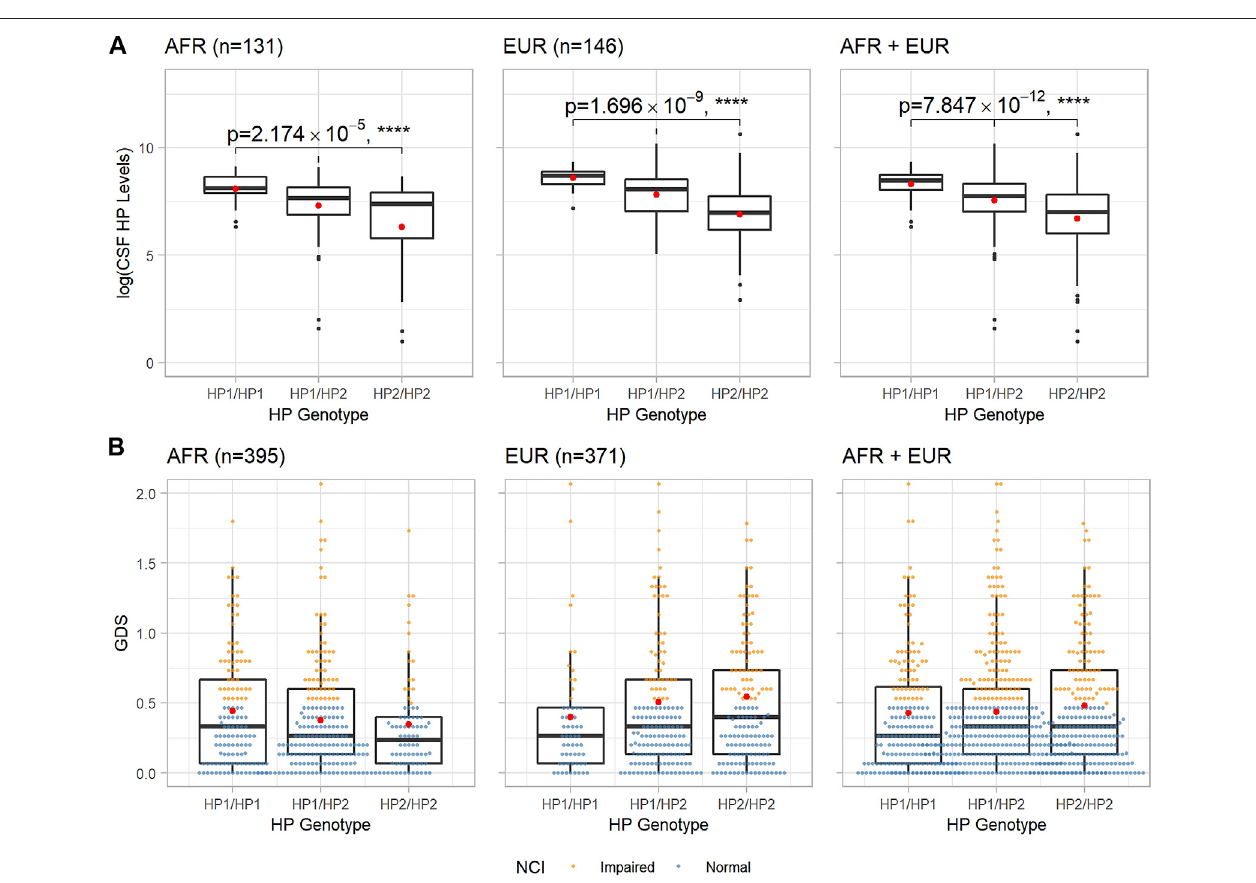
FIGURE 1 | Boxplots of CSF HP protein levels and baseline GDS of each HP genotype in AFR and EUR ancestry groups. (A) : CSF HP protein levels in logarithmic scale vs. HP genotypes. p _values and asterisks indicating level ofsigni fi cance are from the ANOVA F-test. (B) : GDS at baseline vs. HP genotypes. In both panels, within each box, the black horizontal bar indicates the median value, and the red dot shows the mean value.